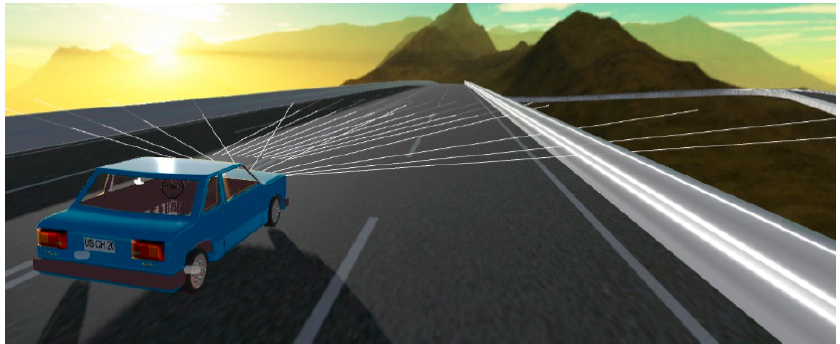
Figure 7. Virtual automobile deploying its distance detection rays on the training track.